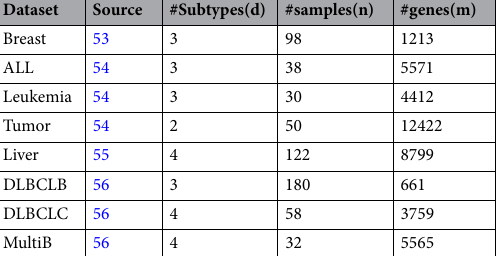
Table 3. Details of 8 cancer gene expression datasets. #Subtypes is the number of cancer subtypes (or clusters), #samples is the number of samples, and #genes is the number of genes.